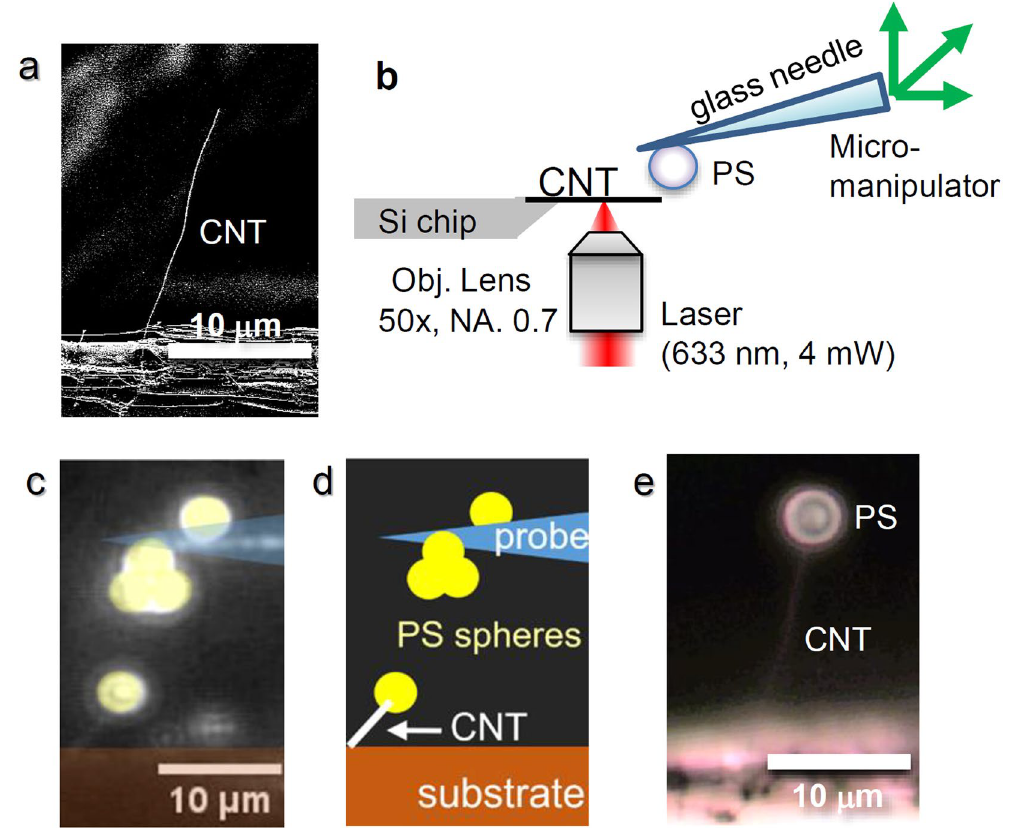
Figure 1. Attachment of PS microsphere to the very tip of the CNT cantilever. ( a ) SEM image of the as- fabricated CNT resonator on a Si chip. ( b ) Optical setup for the laser welding process. ( c ) Optical microscopy image of the CNT cantilever with a PS microsphere and the sharpened glass probe with PS microspheres. (false color, different CNT shown in a and e ) ( d ) Schematic illustration of ( c ). ( e ) Optical micrograph of the CNT resonator after attachment of the PS microsphere with 3 μ m diameter using laser